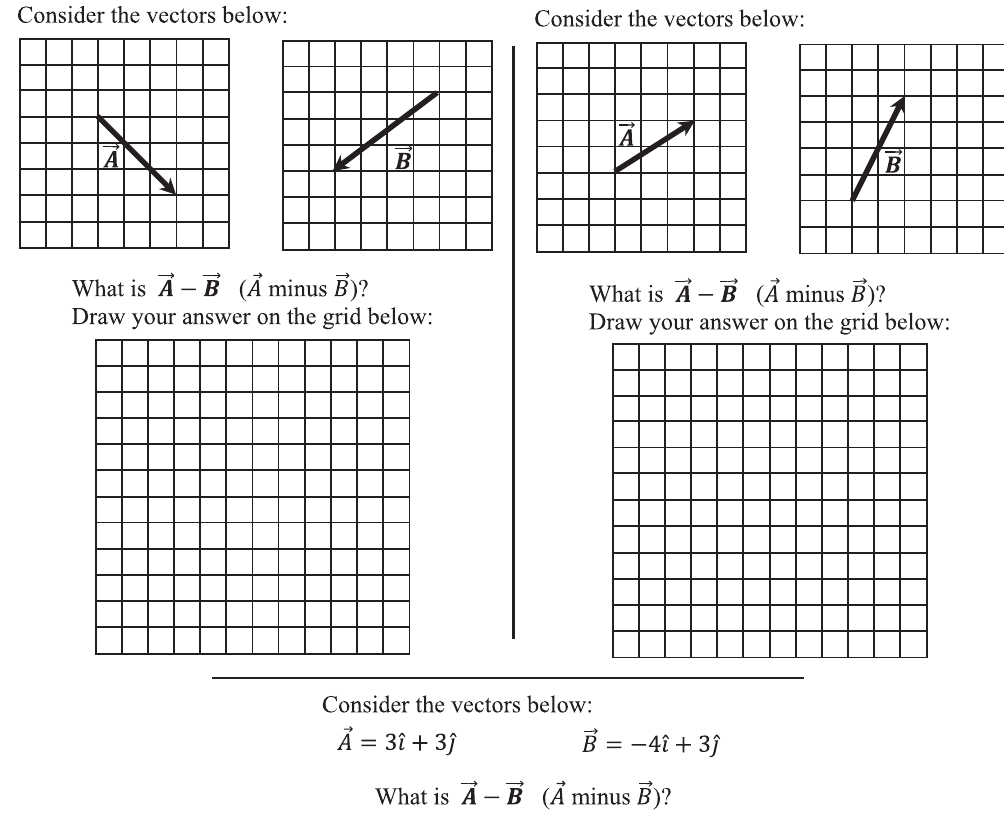
FIG. 3. Examples of two-dimensional subtraction questions in arrow and ijk format.